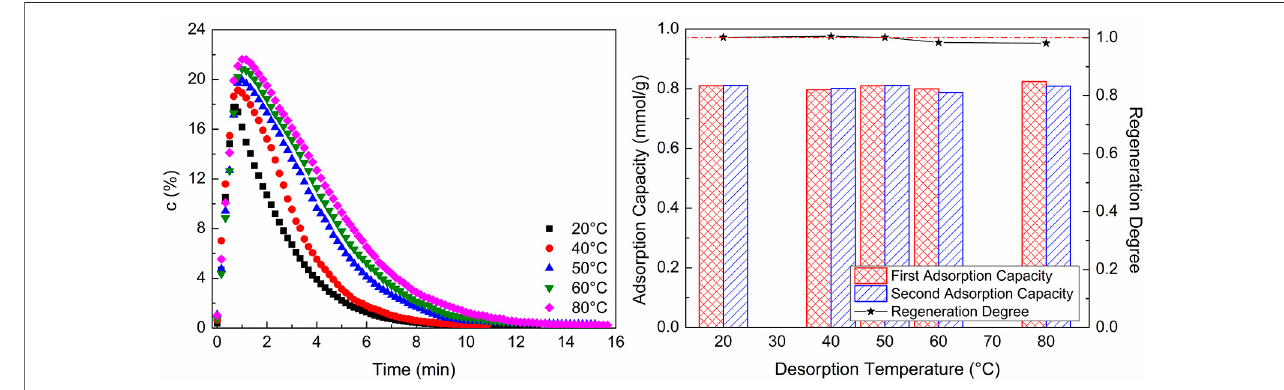
FIGURE 8 | CO 2 desorption properties at different desorption temperatures: (A) CO 2 desorption concentration; (B) adsorption capacity and regeneration degree.